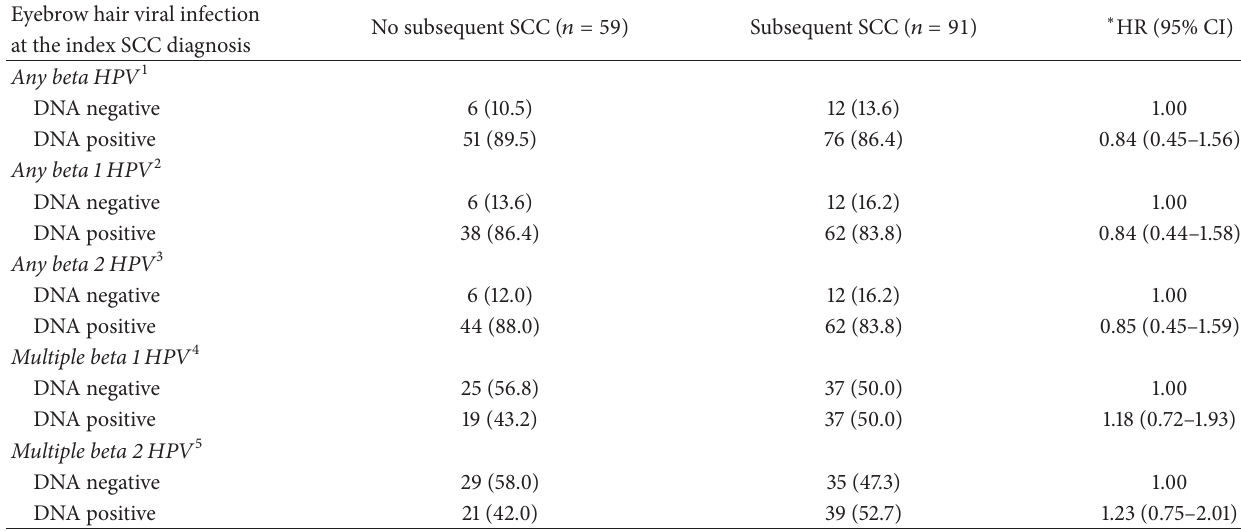
Table 4: Association between cutaneous human papillomavirus (HPV) infection in eyebrow hair and the risk of subsequent squamous cell carcinoma (SCC).